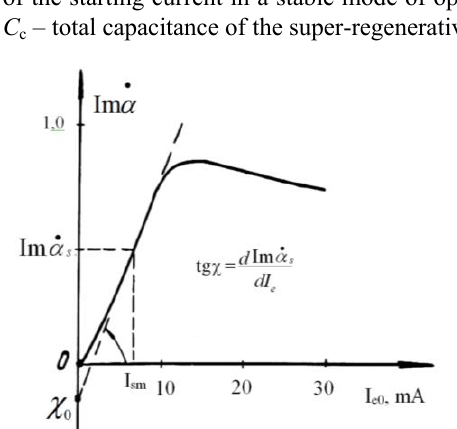
Fig. 3. Linear approximation of the imaginary component of the complex emitter current transfer coefficient in the starting mode of operation of a super-regenerative